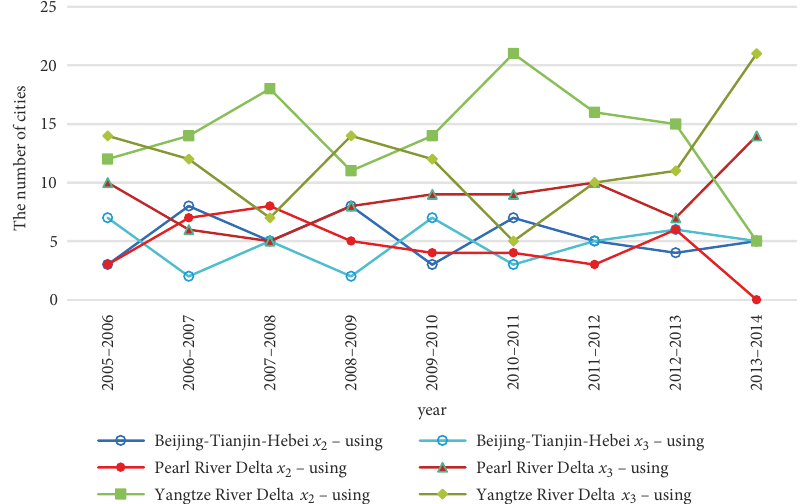
Figure 6. Input biased technological changes of labor ( x 2 ) and electricity consumption ( x 3 ) in each of the urban